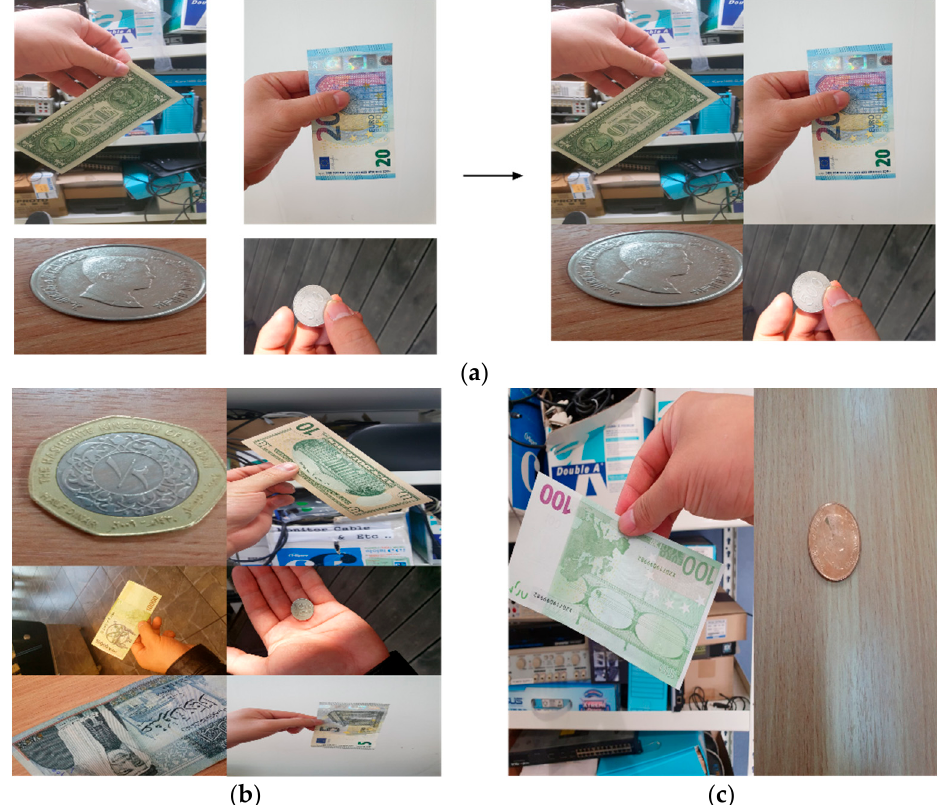
Figure 2. Mosaic data augmentation of banknote dataset: ( a ) is an example of applying four images of mosaic data augmentation, and ( b , c ) are examples of applying six images and two images of mosaic data augmentation, respectively.